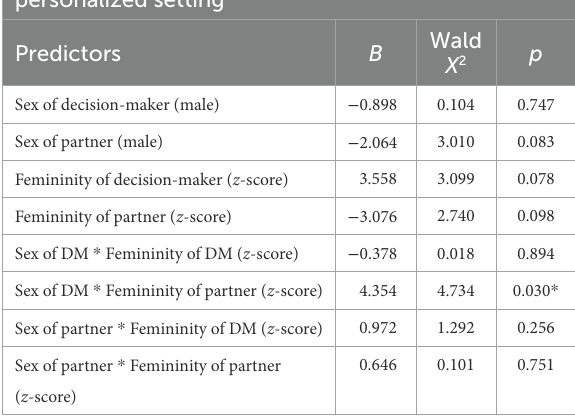
TABLE A2 Shifts in trustworthiness, degree of facial femininity and partners’